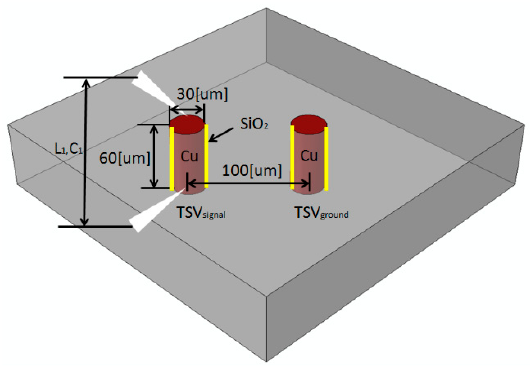
Figure 1. Schematic view of the through-silicon via (TSV) sample.